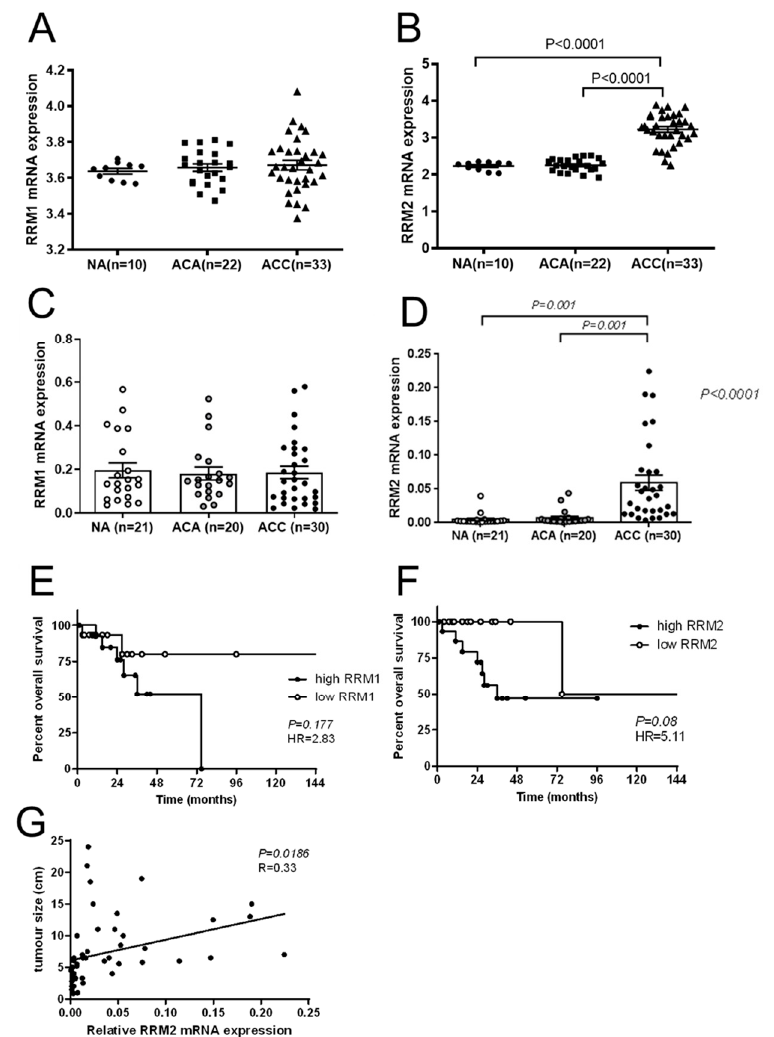
Figure 4. Relative RRM1 and RRM2 gene expression in normal adrenal (NA), adrenocortical adenoma (ACA), and adrenocortical carcinoma (ACC) samples of an available series form the literature [14] ( A , B ) and of our cohort ( C , D ). Kaplan–Meier survival curves for patients with ACC from our cohort according to low or high expression levels of RRM1 ( E ) or RRM2 ( F ). Correlation between the tumor size and the RRM2 expression levels ( G